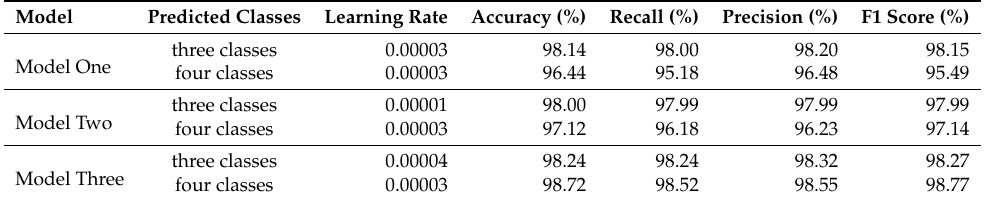
Table 6. Best performance for the three models on the validation dataset. For each model, the perfor- mance metrics for both three classes and four classes are shown, along with the best learning rate. Model Model One